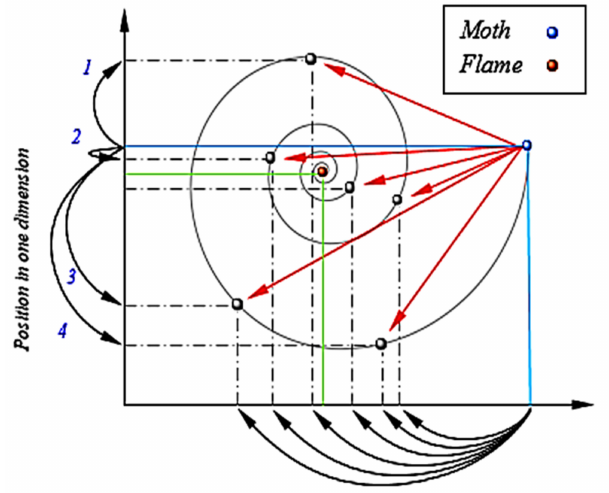
Figure 9. Temporary position that can be reached by a moth with regard to a flame using the logarithmic spiral [34]. (Reproduced with permission by Elsevier publisher,